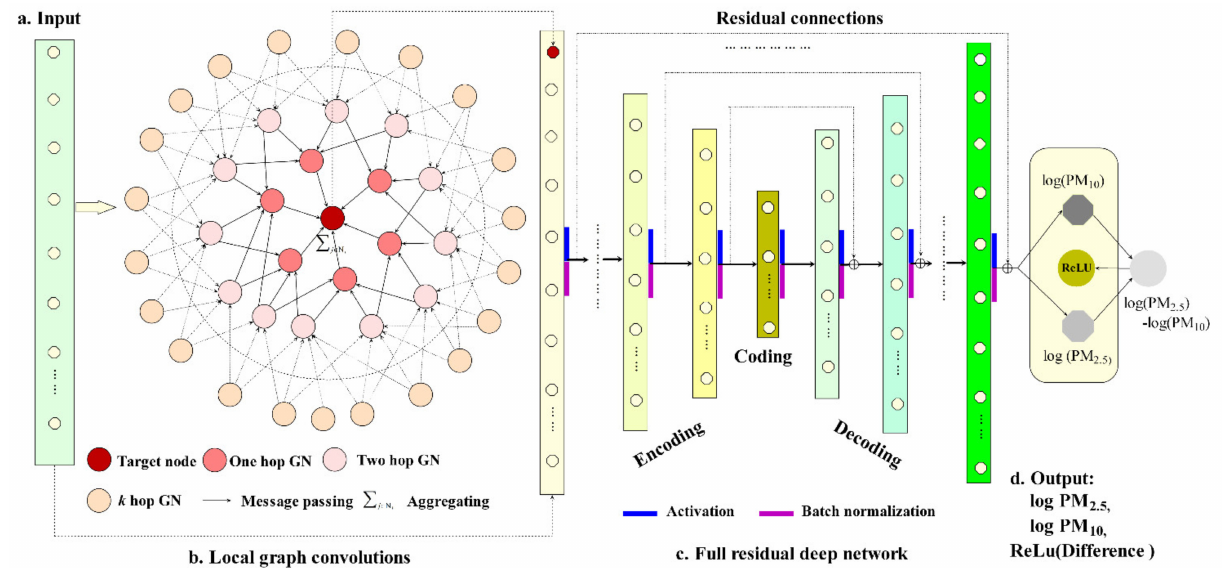
Figure 3. Systematic architecture of geographic (spatiotemporal) graph hybrid